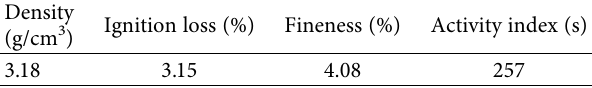
Table 2: Physical properties of magnesium oxide. Density